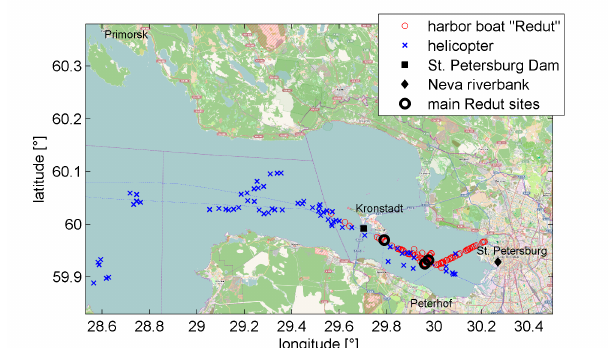
Figure 2. Map overview of the measurement sites. Most of the mea- surements from the harbor boat Redut were performed from the main Redut sites. Some during the passage between these sites and the port. (Map data © OpenStreetMap)